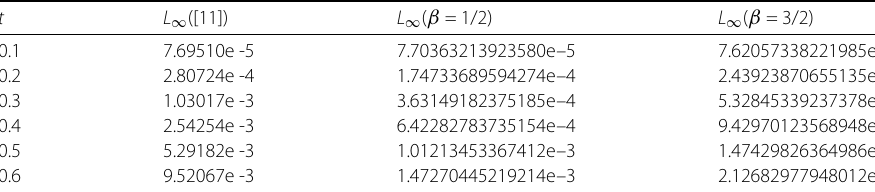
Table 7 Comparison of L ∞ errors of Example 2, for α = 1 and various values of t t L ∞ ([11]) L ∞ ( β = 1/2) L ∞ ( β = 3/2)